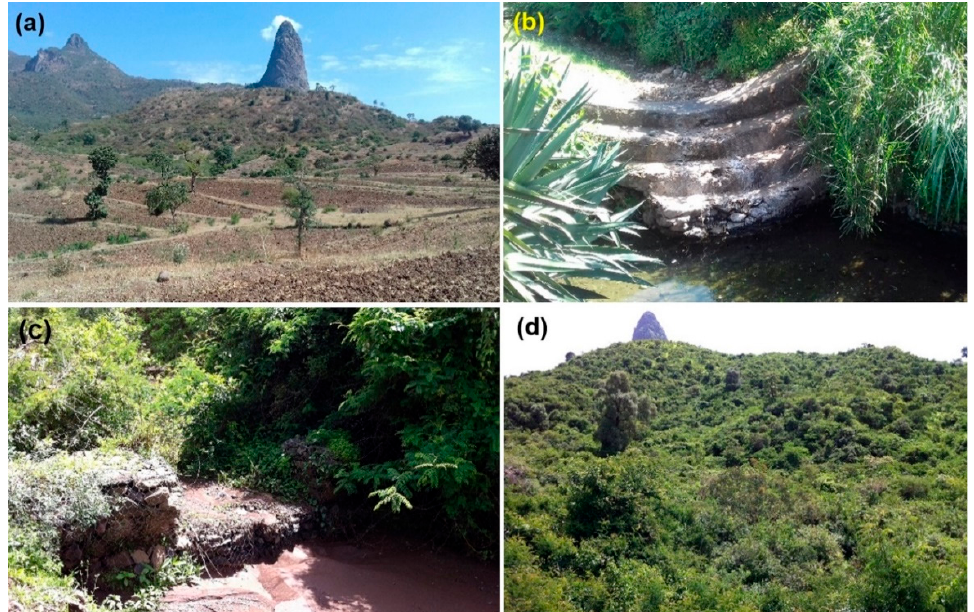
Figure 2. Physical and biological conservation practices in Gomit watershed: ( a ) bunds with trachyte plug in the background, ( b ) arc-weir, ( c ) gabion check dam, and ( d ) protected forested land.